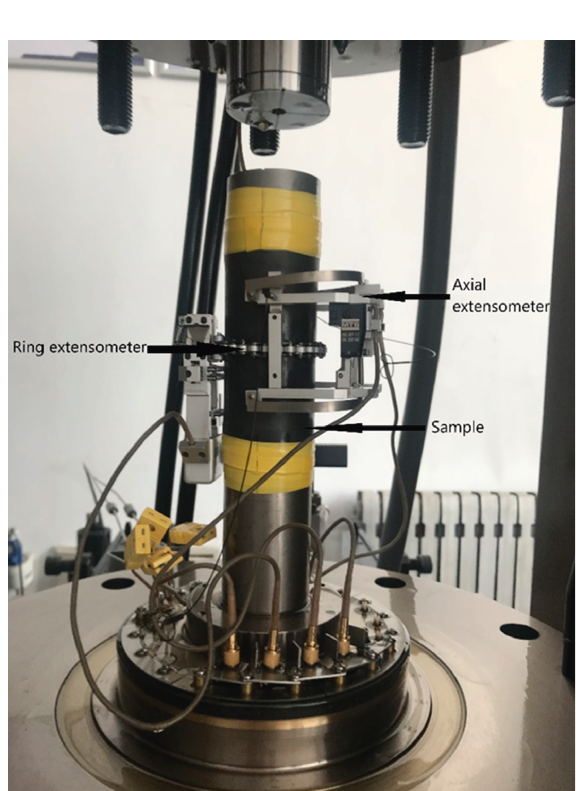
Figure 1: Sample